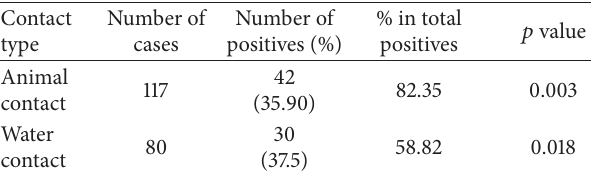
Table 2: Animal and water contact pattern in